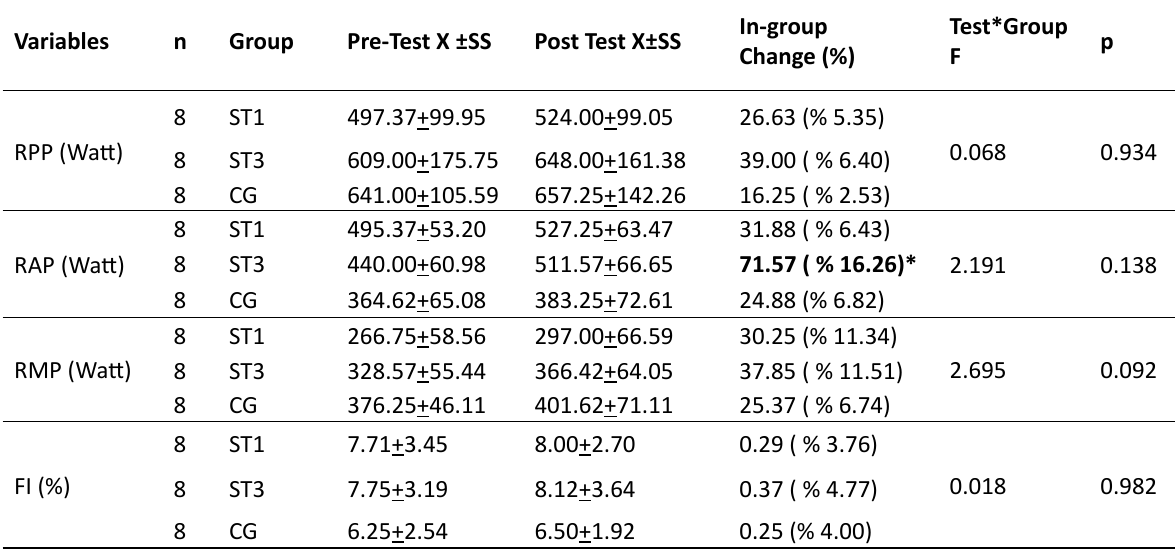
Table 5. Comparison of pre and post-test changes of RAST among groups